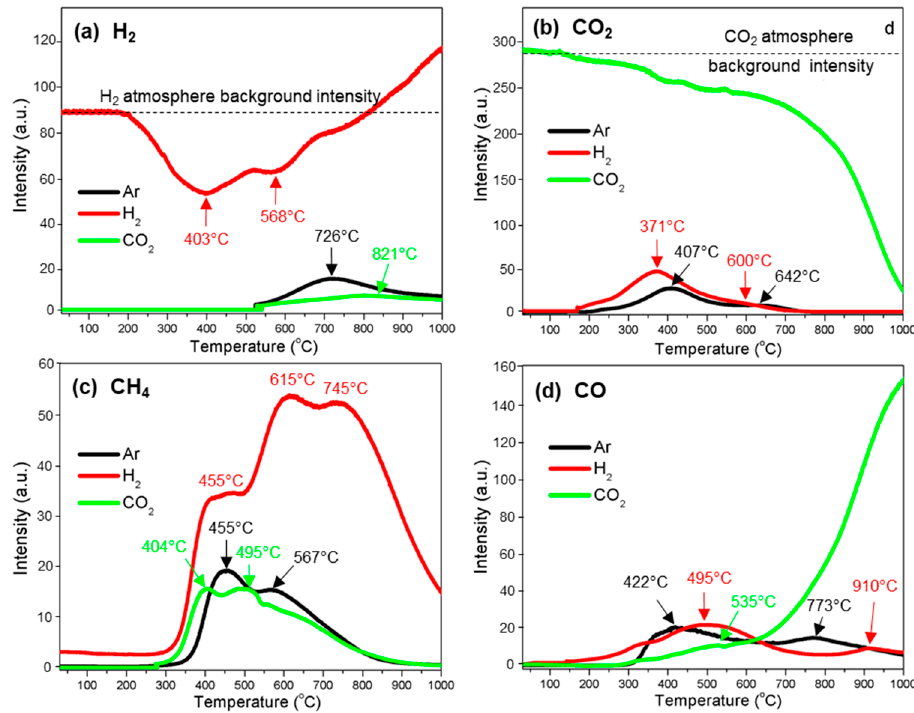
Figure 3. Gas evolution profiles of the thermal decomposition of kraft lignin under argon (Ar), hydrogen (H 2 ), and carbon dioxide (CO 2 ) atmospheres: ( a ) H 2 ; ( b ) CO 2 ; ( c ) CH 4 ; and ( d ) CO.